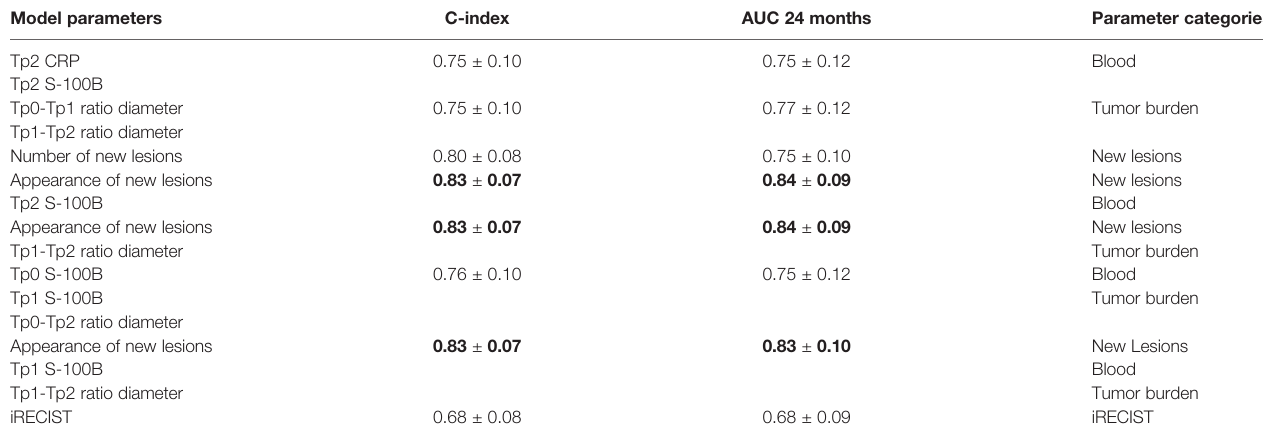
TABLE 5 | Best performing multivariate Cox models after 100x-repeated 5-fold cross-validation. Models are categorized according to parameters used: blood, tumor burden, and appearance of new lesions as well as combinations of them. iRECIST was included for comparison. Models showing statistically signi fi cant (p < 0.05) improved performance compared to iRECIST are in